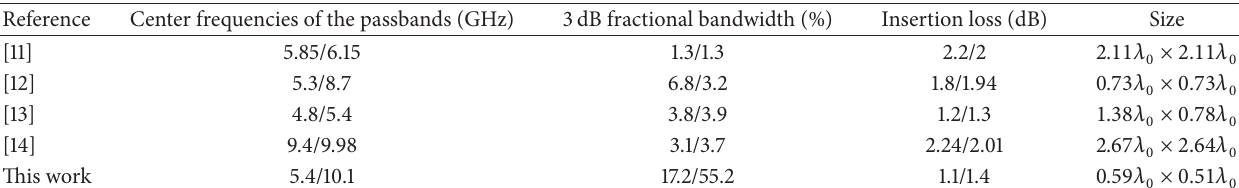
Table 2: Performance comparisons with other recent published SIW filters.